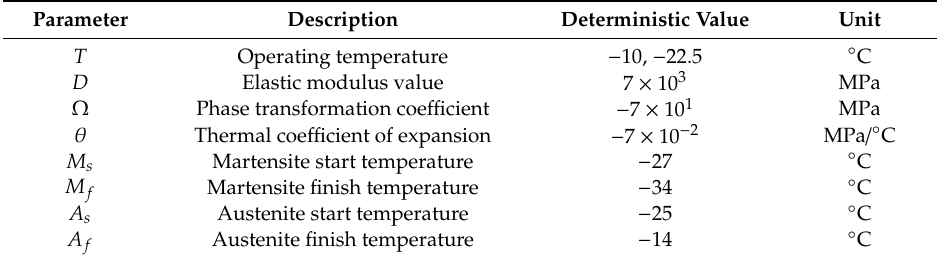
Table 1. Material properties for Cu-Zn-Sn